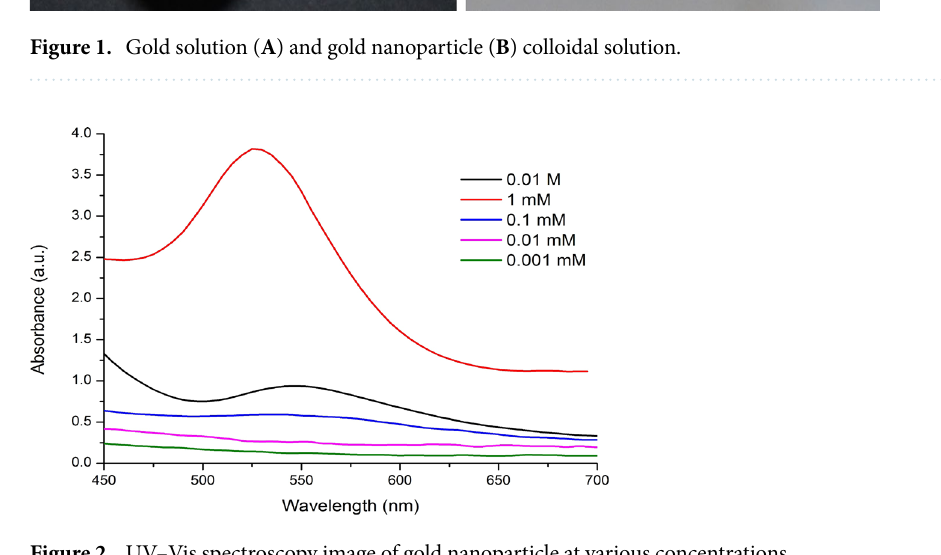
Figure 2. UV–Vis spectroscopy image of gold nanoparticle at various